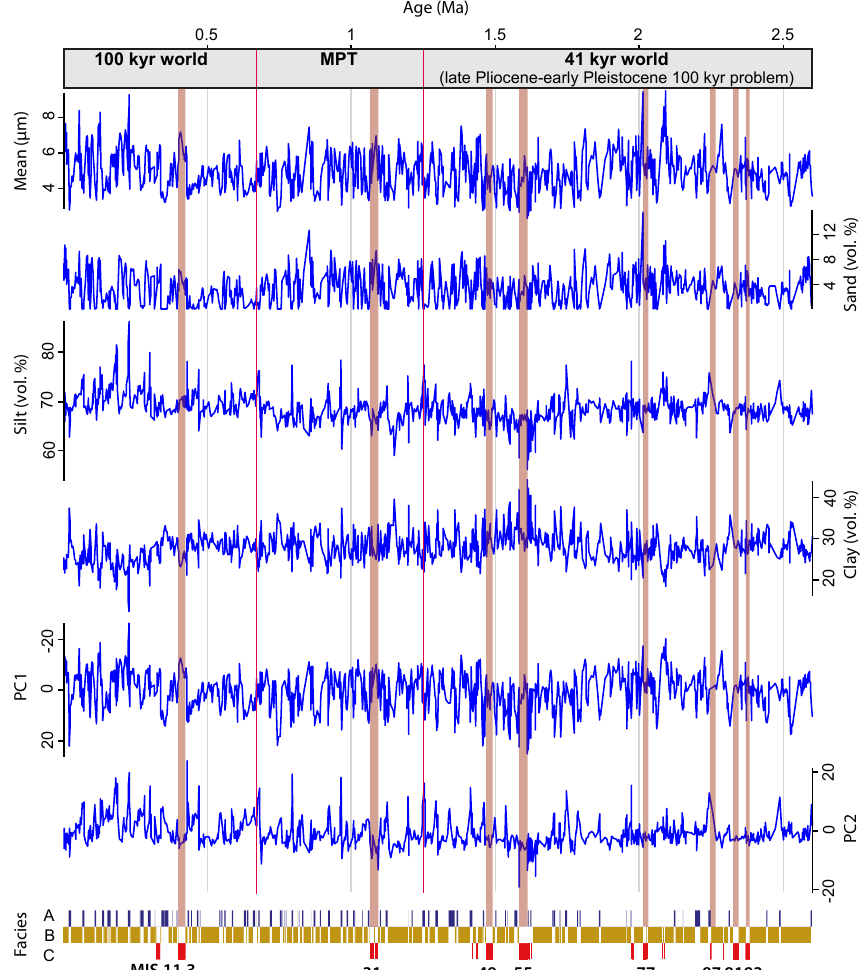
Fig. 2. Selected grain-size parameters (mean, sand, silt, clay) and sample scores of PC1 and PC2 in the Quaternary sediments of the core composite at ICDP site 5011-1 in central Lake El’gygytgyn. The timing of the Middle Pleistocene transition (MPT) from the 41kyr world, including the Pliocene–early Pleistocene 100kyr problem after Nie et al. (2008), to the 100kyr world is derived from the time series analysis (cf. Fig. 6). Facies bar was modified from Melles et al. (2012); marine isotope stages of “super interglacial” facies C (after Melles et al., 2012) are labeled